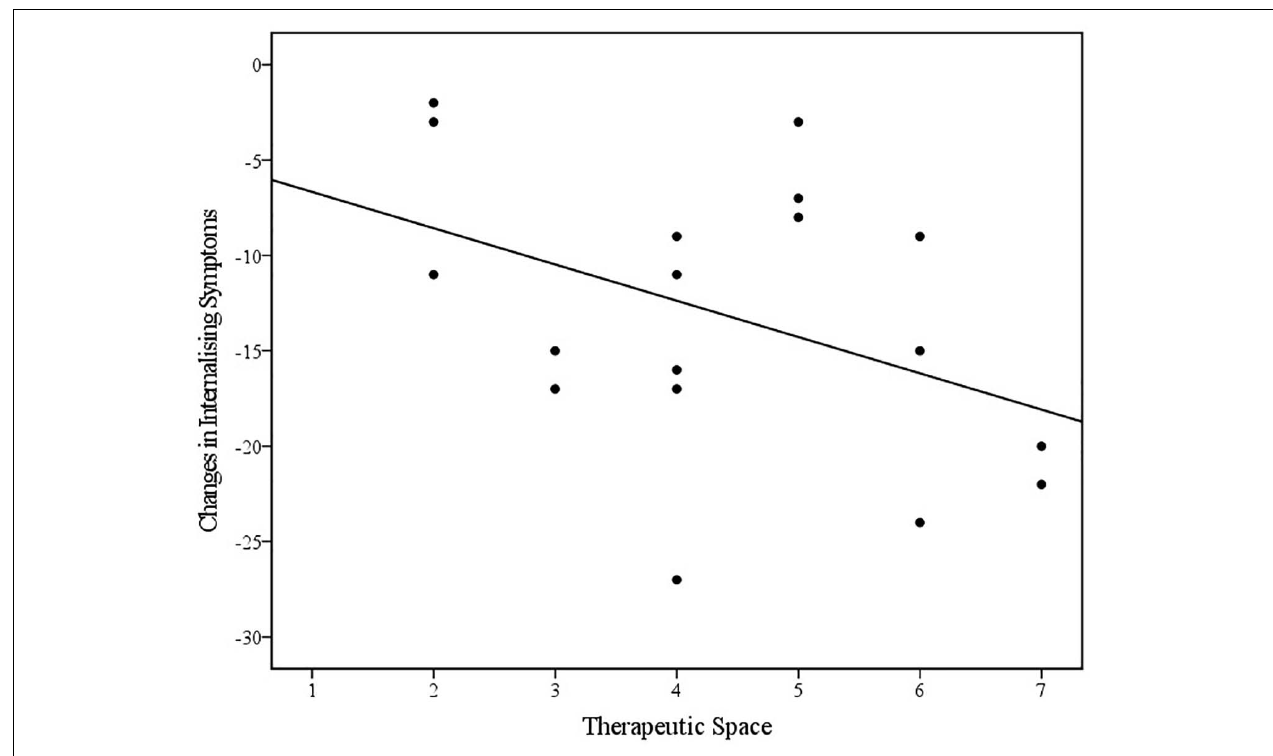
FIGURE 6 | Scatterplot and line of best fit (linear) illustrating the relationship between use of Therapeutic Space and changes in Internalising Symptoms on the CBCL across treatment ( N = 18) (Linear equation: y = –4.76–1.9 × ; R 2 =